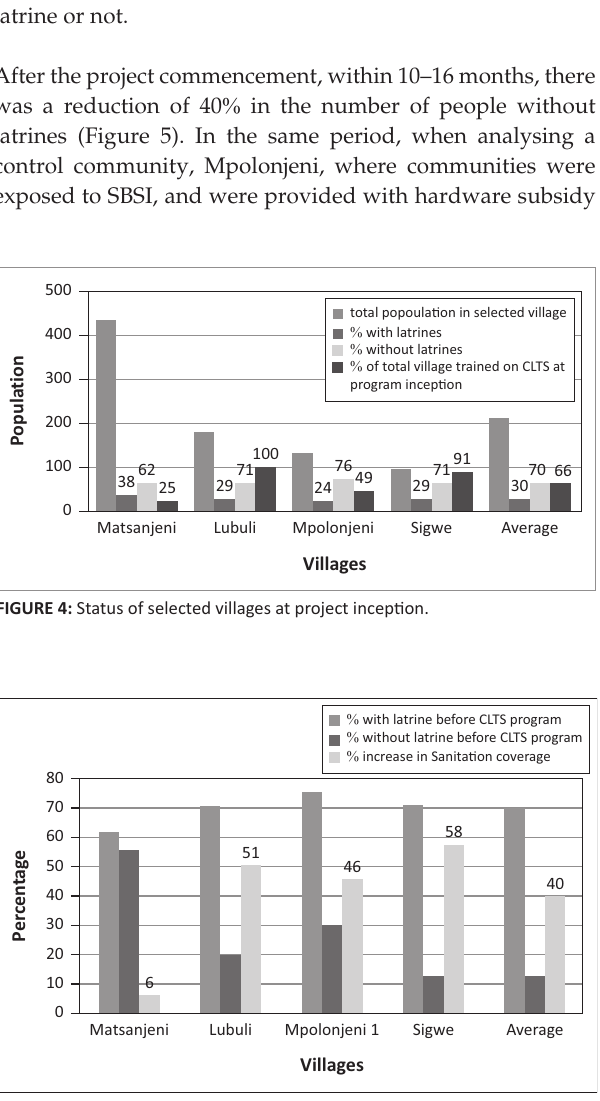
FIGURE 5: Change in sanitation coverage of selected villages after Community Led Total Sanitation intervention.